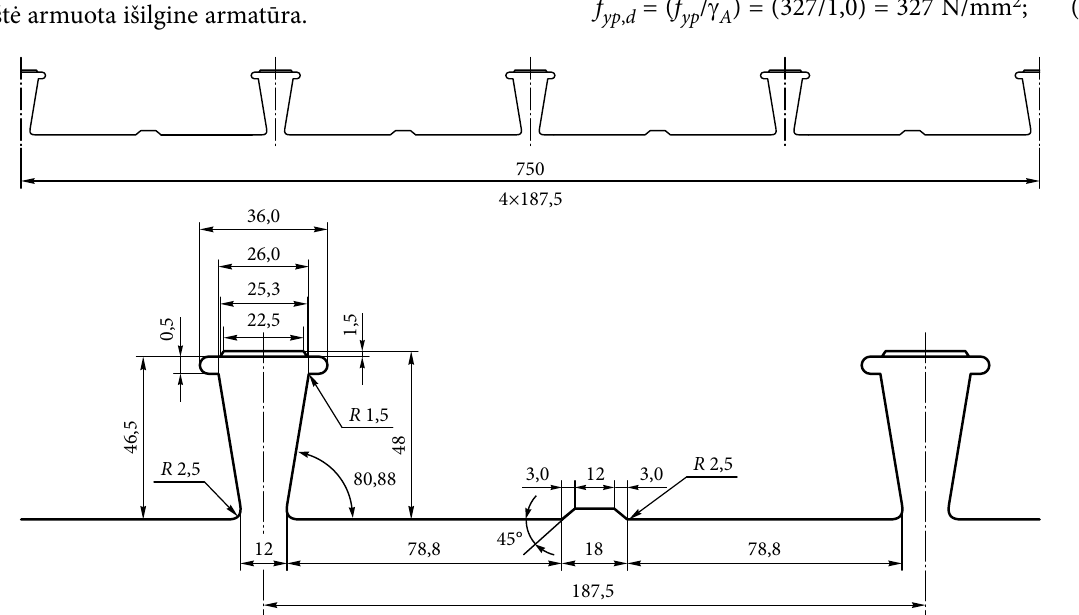
Fig. 13. Geometric model of re-entrant profiled